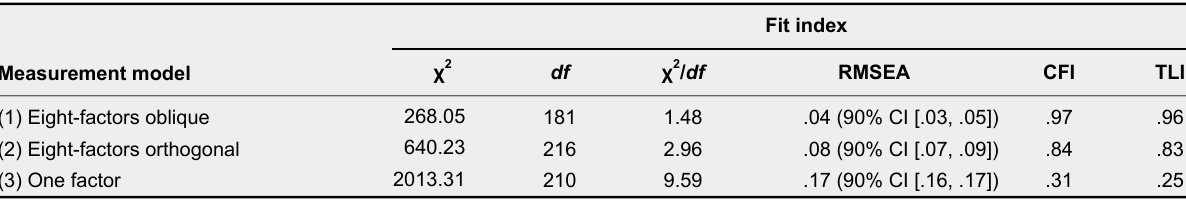
Comparison of Fit Indices of the Hypothesized Measurement Model (Eight-Factor Oblique), the Second Measurement Model (Eight-Factor Orthogonal), and the Third Measurement Model (One